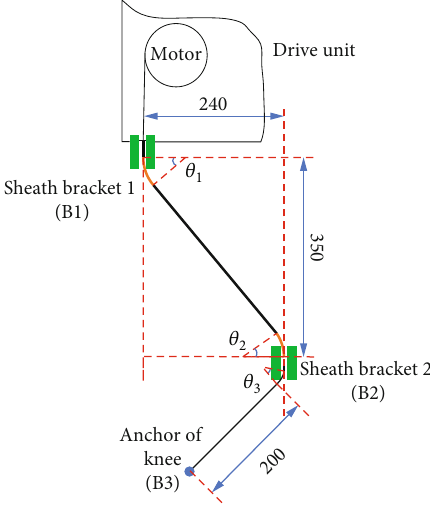
Figure 3: The sketch of 2-D form of Bowden cable on